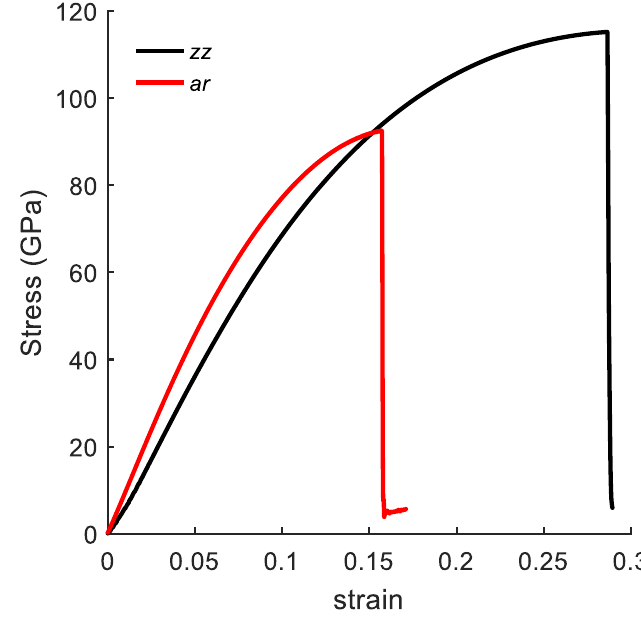
Figure3. Stress–straincurvesofpristinegraphenesheetunderuniaxialtensionalong ar and zz Figure 3. Stress–strain curves of pristine graphene sheet under uniaxial tension along ar and zz directions.